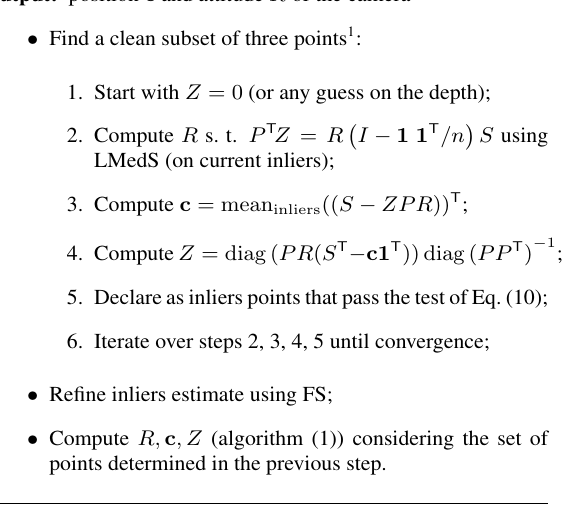
Algorithm 2 R OBUST P ROCRUSTEAN E XTERIOR O RIENTA -